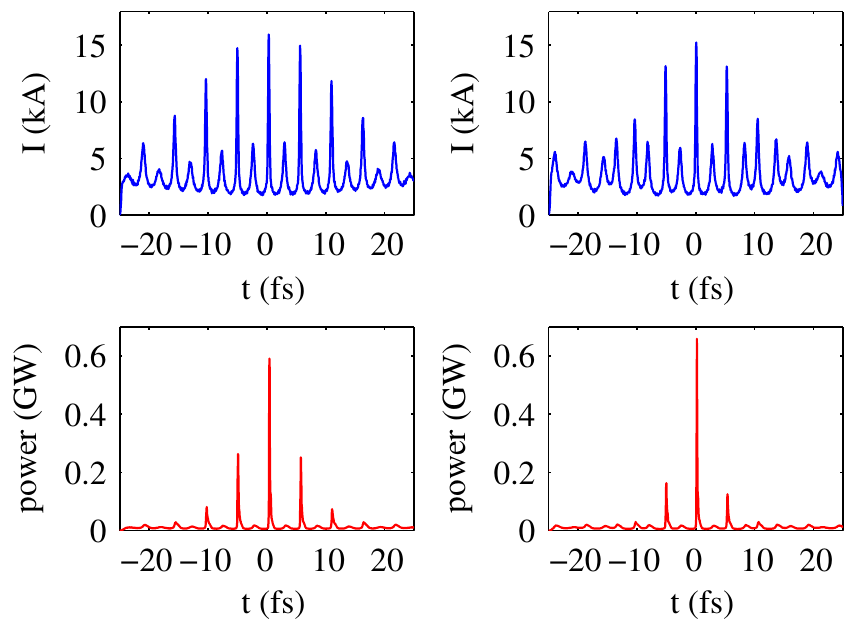
FIG. 9. (Color) Current profiles (top) and radiation pulses (bottom) versus detuning of the second laser wavelength. Left: laser-2 wavelength of 1 : 6 (cid:1) m ; Right: laser-2 wavelength of 1 : 45 (cid:1) m